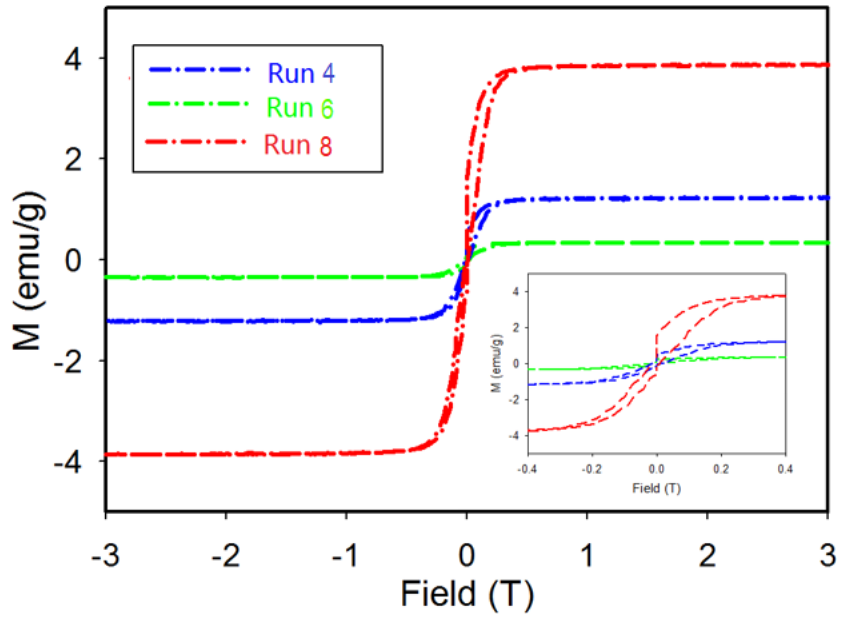
Figure 8. Field dependent magnetization at 100 K for samples from Run 4, Run 6, and Run 8. Inset: Detailed view of magnetization at low field.